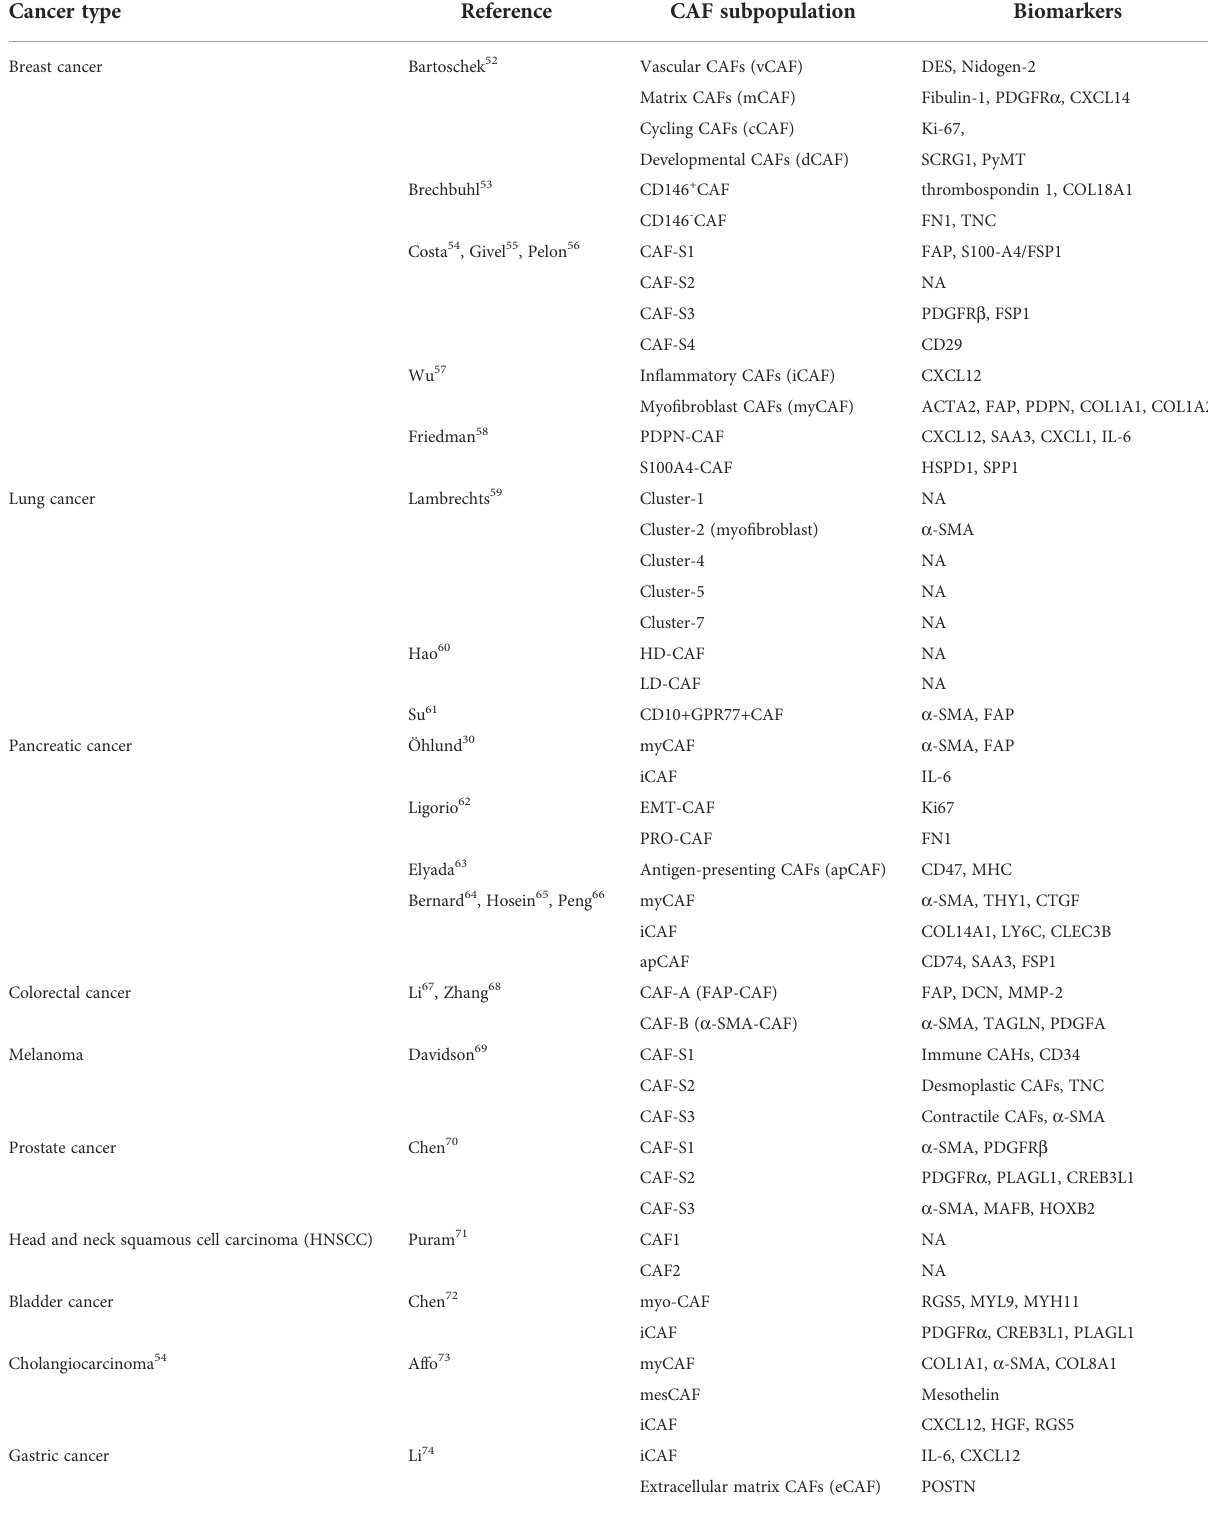
TABLE 1 The proposed classi fi cation of CAFs in different cancer